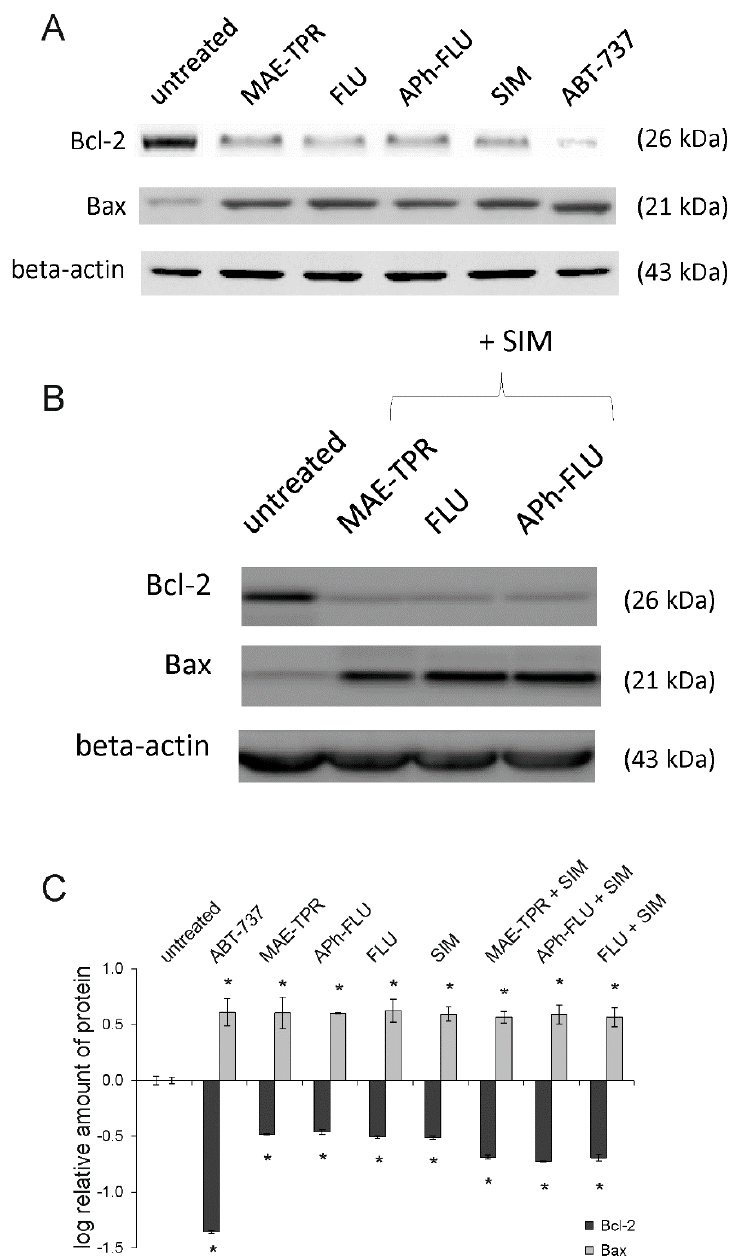
Figure 7. Analysis of Bcl-2 (dark grey bars) and Bax proteins (light grey bars) expression in LoVo/Dx cells cultured for 48 hours with phenothiazine derivatives and simvastatin (SIM) as single agents ( A ) and phenothiazine derivatives in combination with simvastatin ( B ). The molecular masses of the proteins are indicated at the right side of the gel. β -actin was used as a reference protein. ABT-737 was used as a positive control. The log of relative level of Bcl-2 and Bax expression ( C ) normalized to the control derived from non-treated LoVo/Dx cells. The results of three experiments ± SD are presented. The statistically significant differences from the untreated controls were determined using the Student’s t -test (* p < 0.05).